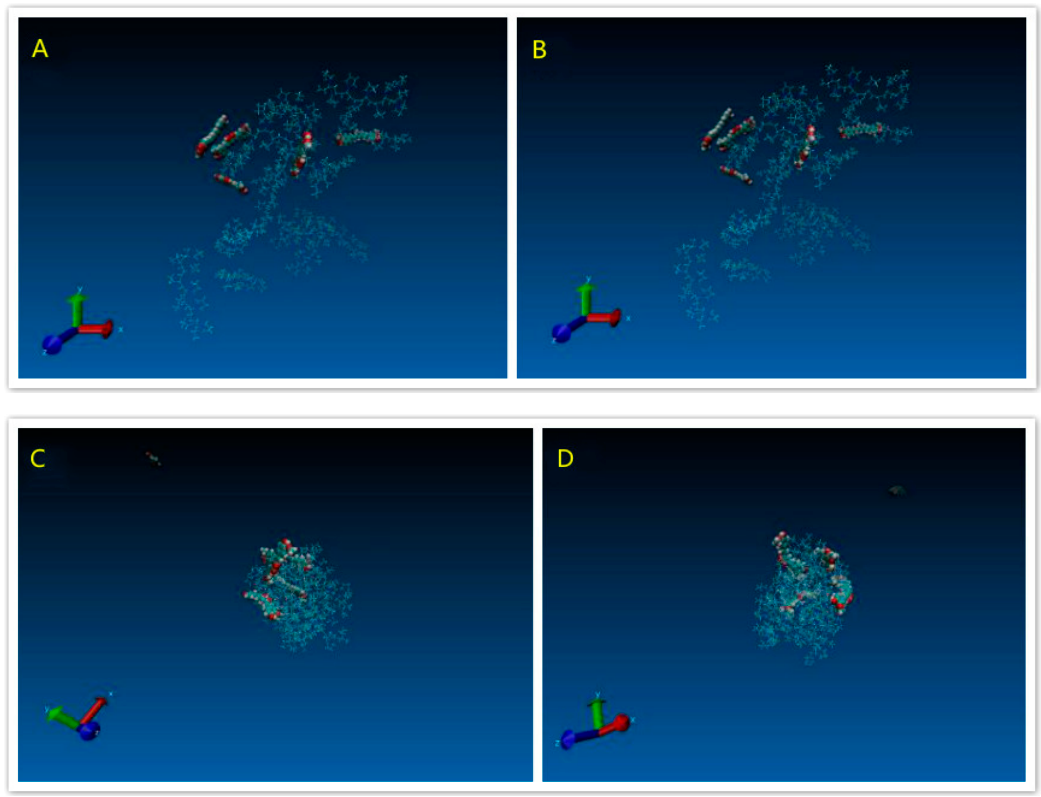
Figure 9. Snapshots of PVP/Cur solid dispersion systems: ( A ) Initial structure system; ( B ) structure after minimization procedure; ( C ) system structure after 4 ns molecular dynamics (MD); and ( D ) system structure after 4 ns MD (different side).